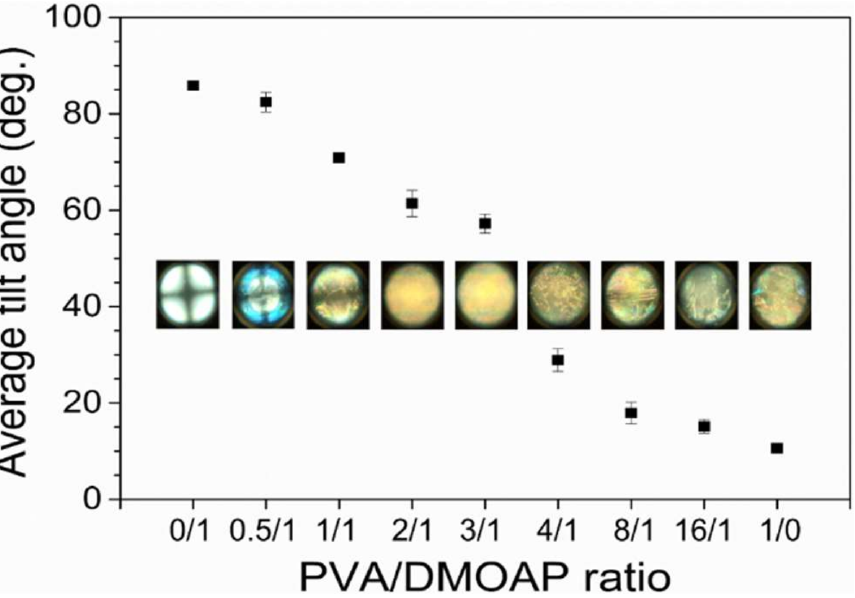
Figure 4. Average tilt angle of E7 as determined by capacitance measurements. The nematic LC E7 was sandwiched between two ITO-coated glass substrates covered with the PVA/DMOAP aligning agent. The average tilt angle was calculated by Equation (1) and plotted against the PVA/DMOAP mass ratio. Error bars represent standard deviations calculated from at least three independent measurements. Corresponding conoscopic micrographs at distinct PVA/DMOAP mass ratios are displayed for